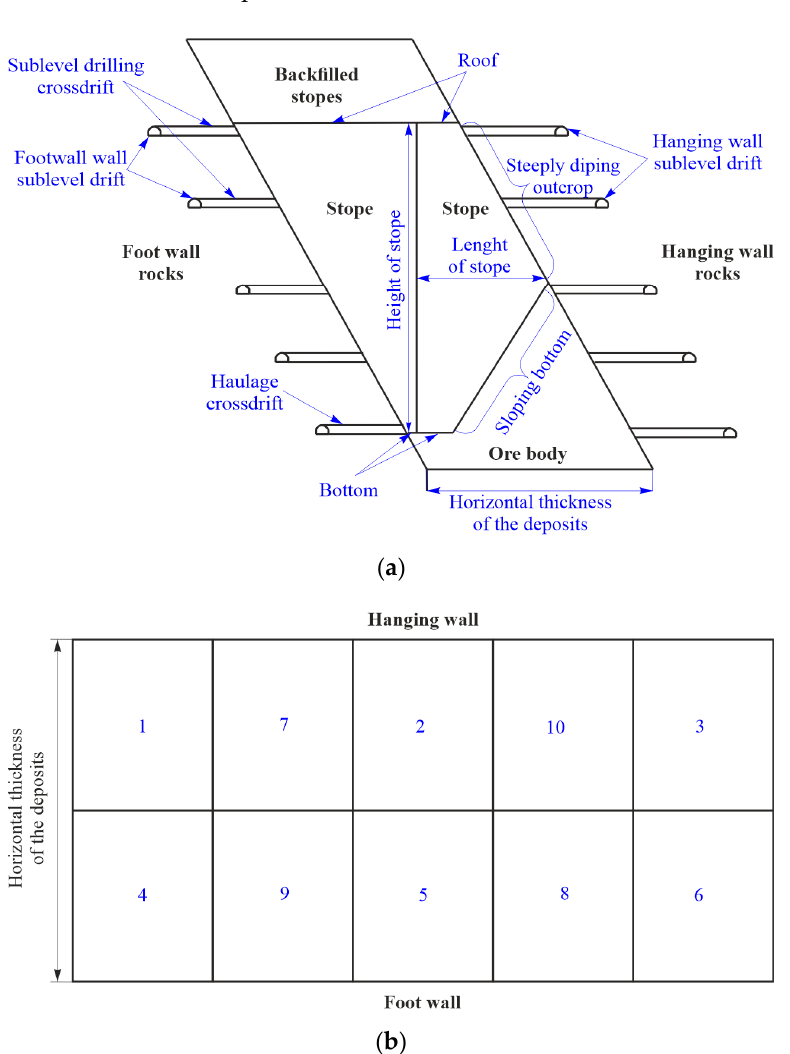
Figure 2. Technological elements of mining the ore deposit: ( a ) division of the deposit into stopes across the strike and its elements; ( b ) order of mining the stopes along the ore deposit area.